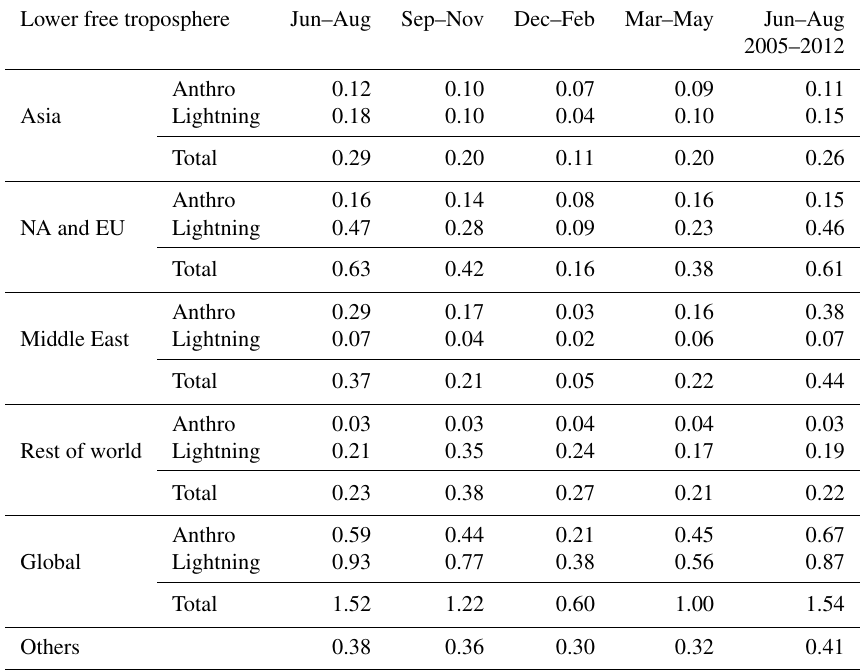
Table 2. Response of lower free tropospheric (700–600hPa) O 3 over Middle Eastern Asia (30–60 ◦ E, 20–40 ◦ N) to NO x emission perturba- tion in the period of March 2005–February 2006. The last column shows the multiyear mean value for June–August